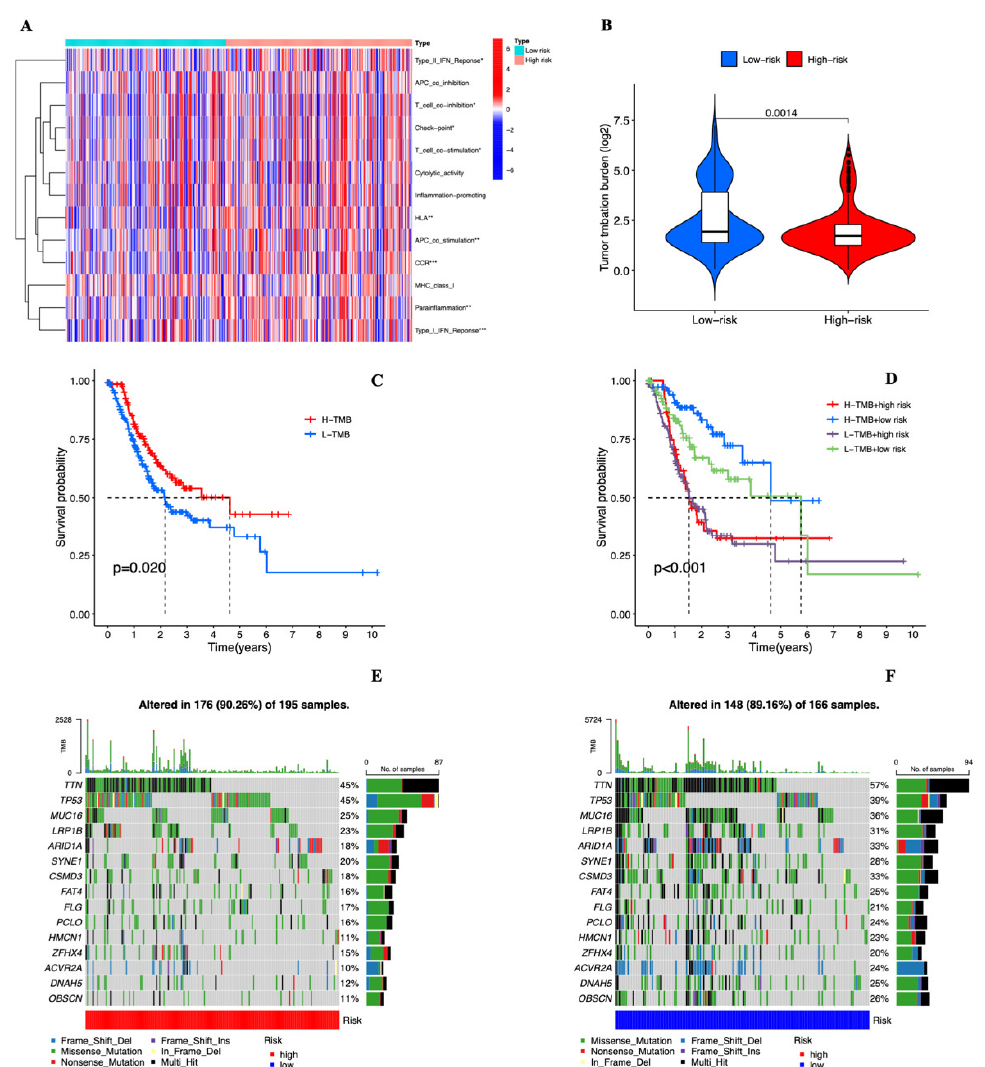
Figure 9. ( A ) The ssGSEA scores of immune cells and immune function in the high- and low-risk groups. “ssGSEA”, single sample gene set enrichment analysis. ( B ) The TMB in STAD patients between the high-risk and low-risk groups. TMB, tumor mutational burden; p < 0.05, statistically significant. ( C ) Higher TMB levels demonstrated poorer OS, p < 0.05, statistically significant. ( D ) Kaplan–Meier curves for patients by both risk score and TMB, p < 0.05, statistically significant. ( E , F ) Waterfall plots of somatic mutation characteristics in the high- and low-risk groups.